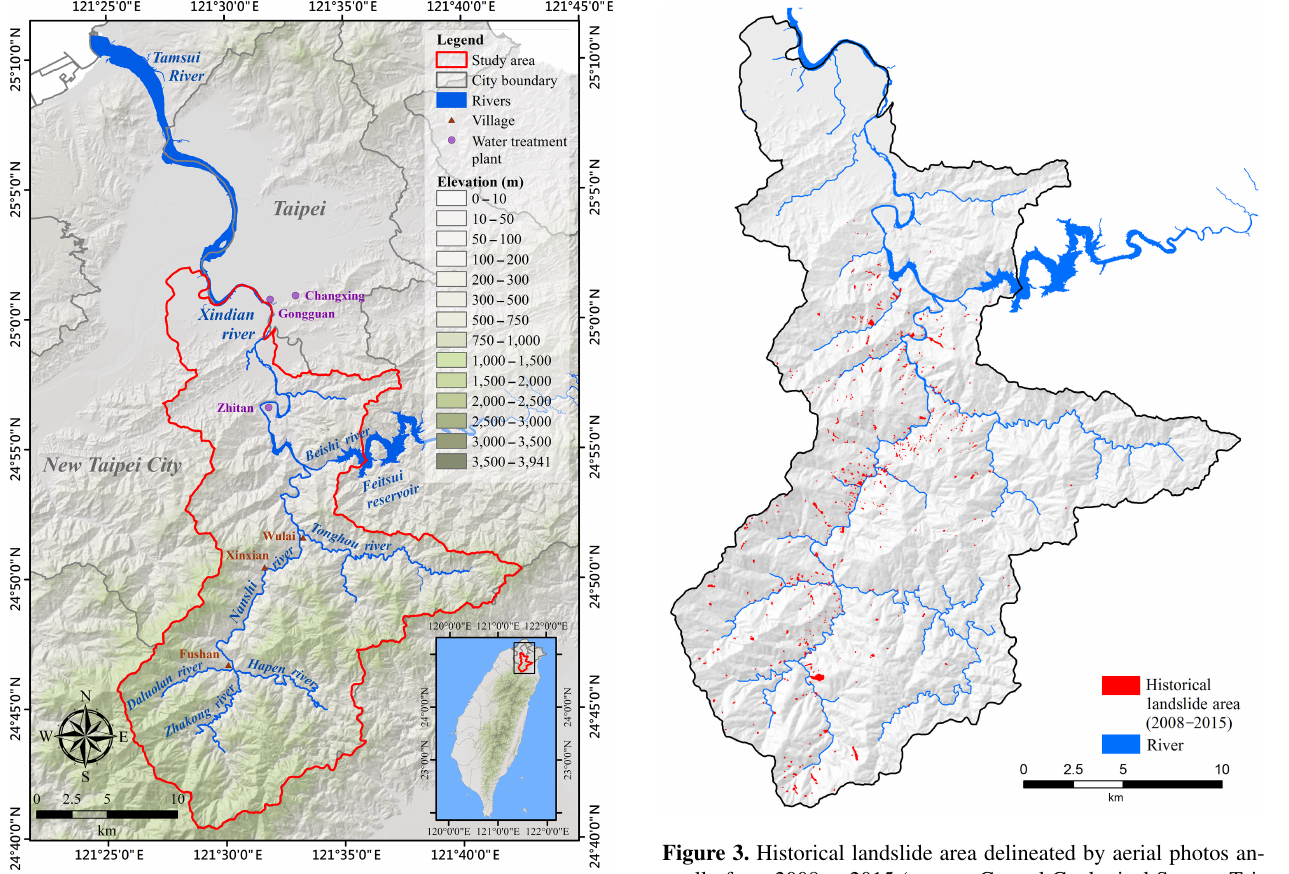
Figure 2. Topography (shaded relief) and location of the study area.